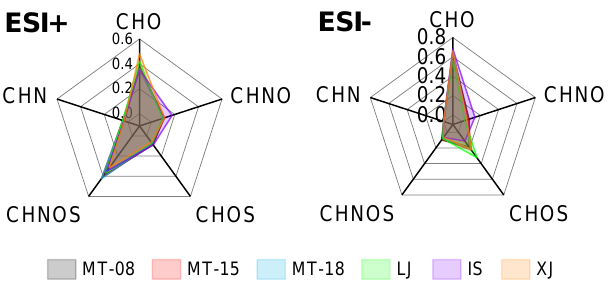
Figure 2. Radar diagrams show the contribution of the main subcategories measured by ESI+ ( left ) and ESI − ( right ).